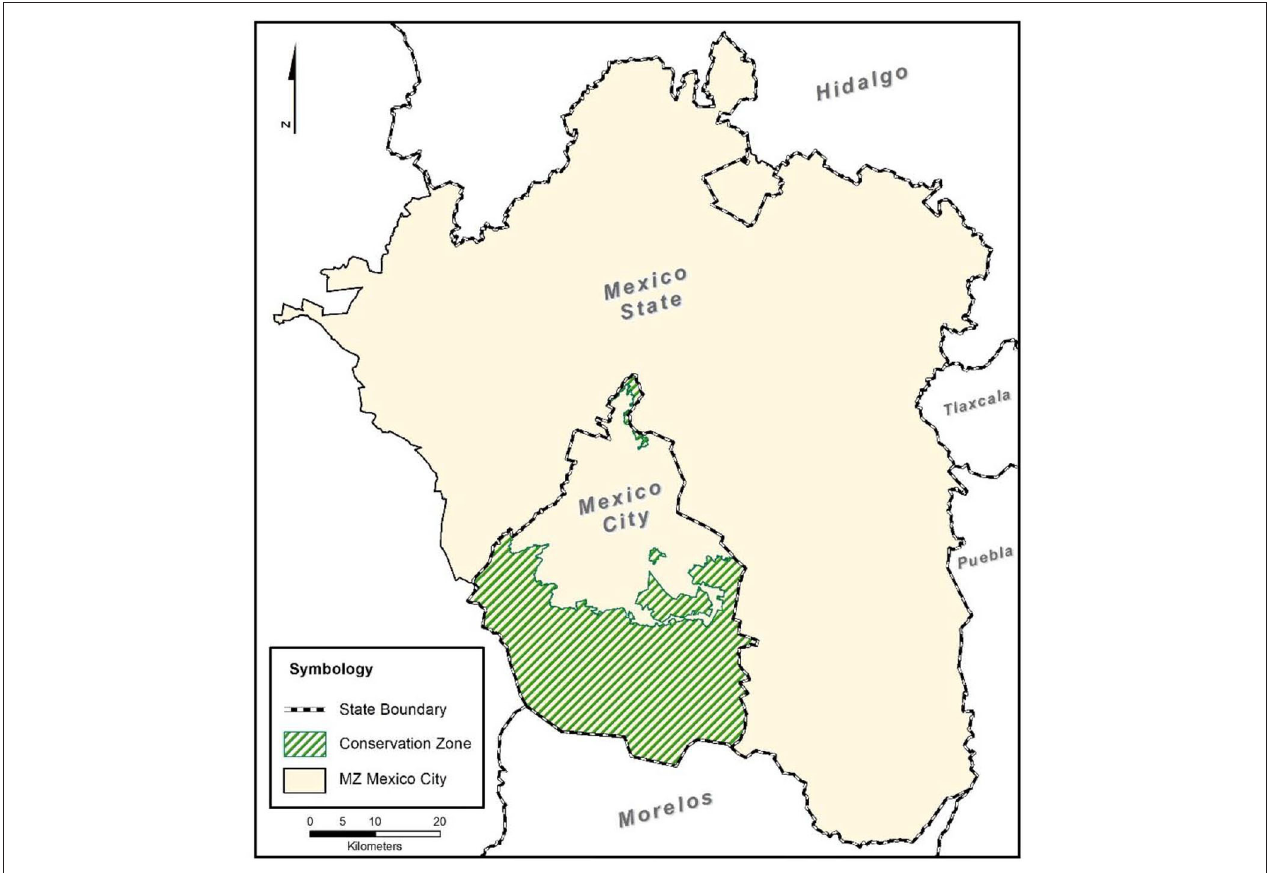
FIGURE 1 | Metropolitan zone of Mexico City. Location of the conservation zone. Elaborated from GDF, 2012, CONAPO, 2015, and INEGI, 2020.